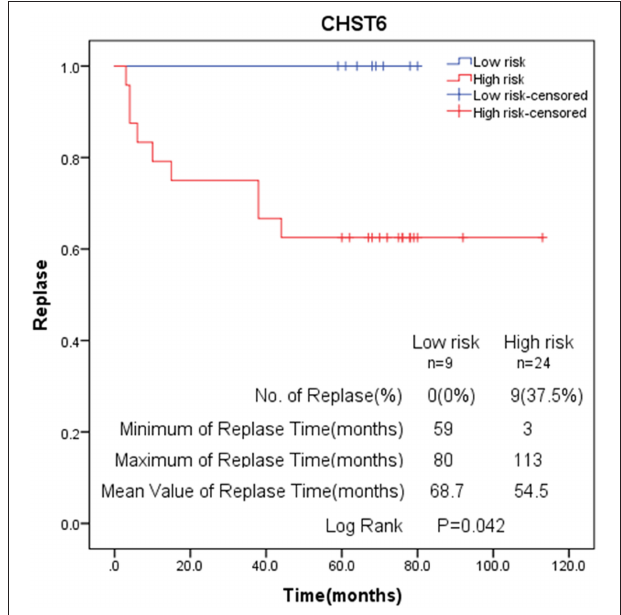
FIGURE 8 | Kaplan–Meier analysis of recurrence rate according to CHST6 expression level.